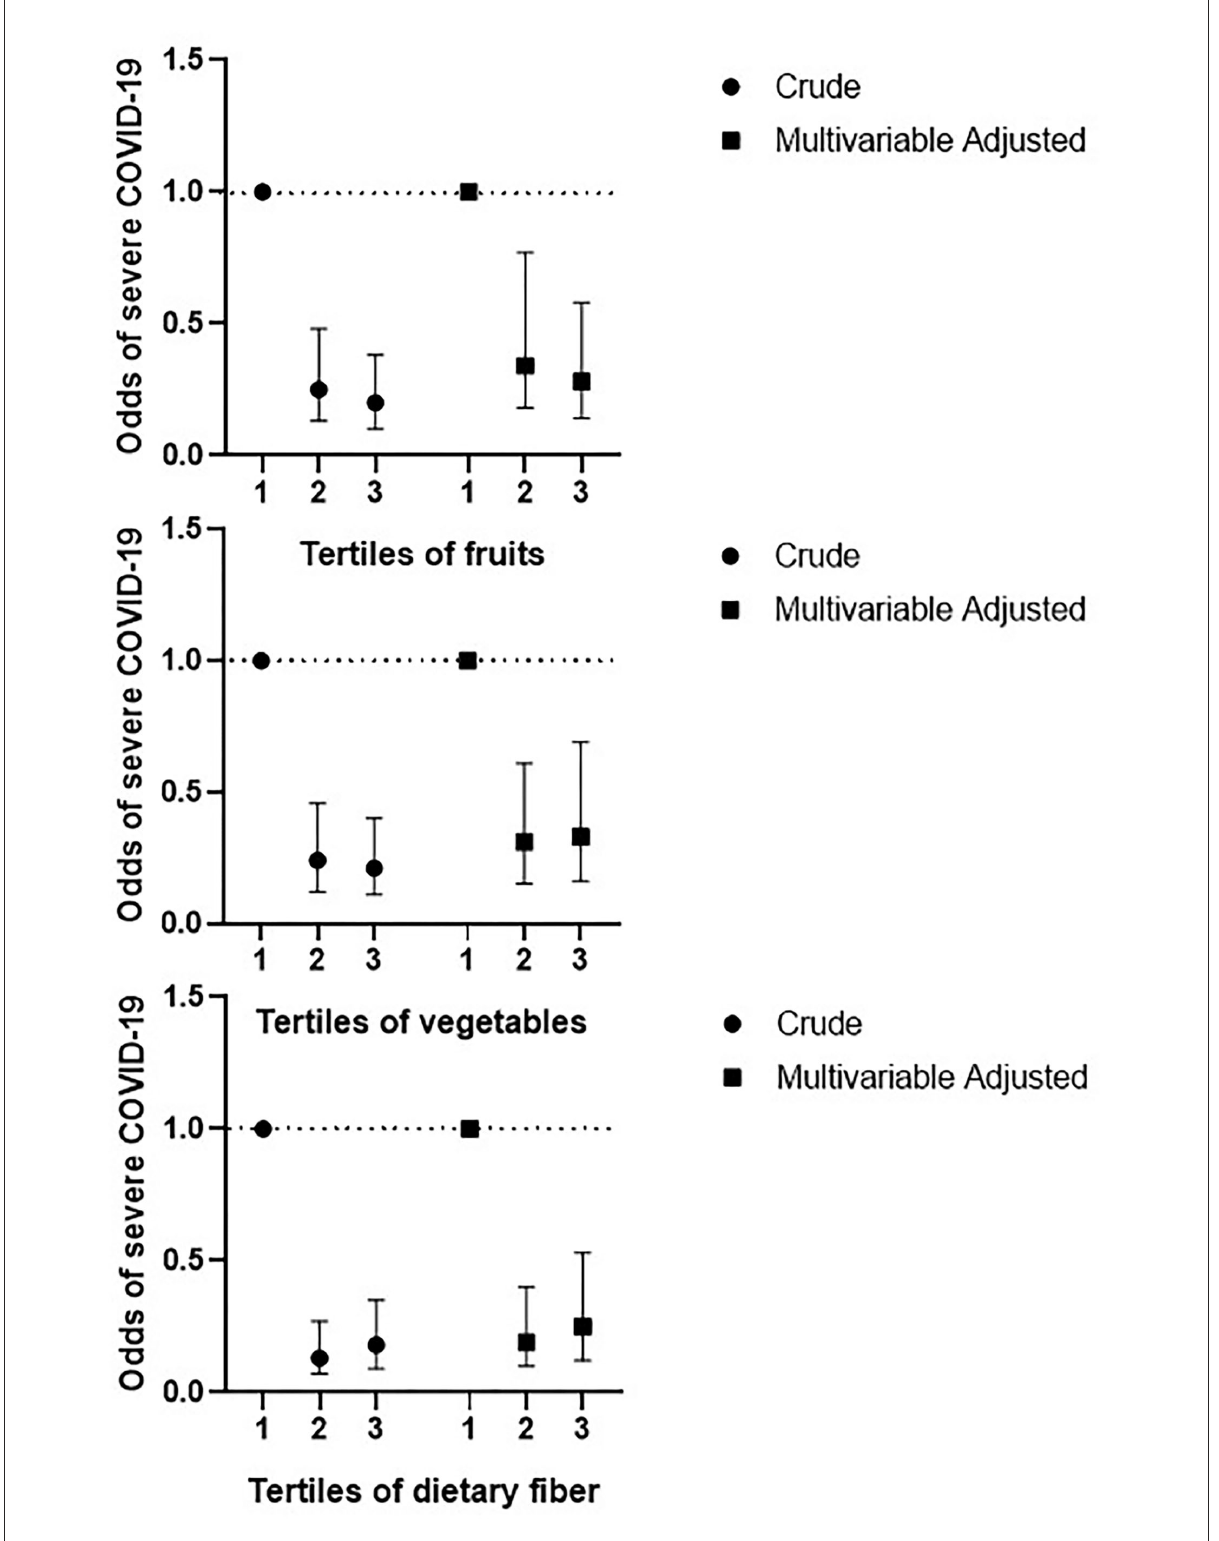
FIGURE1 Crude and multivariable-adjusted odds ratios and 95% CIs of severe COVID-19 disease according to tertiles of dietary fruits, vegetables, and fiber. Multivariable adjusted for age, BMI, energy intake, and physical